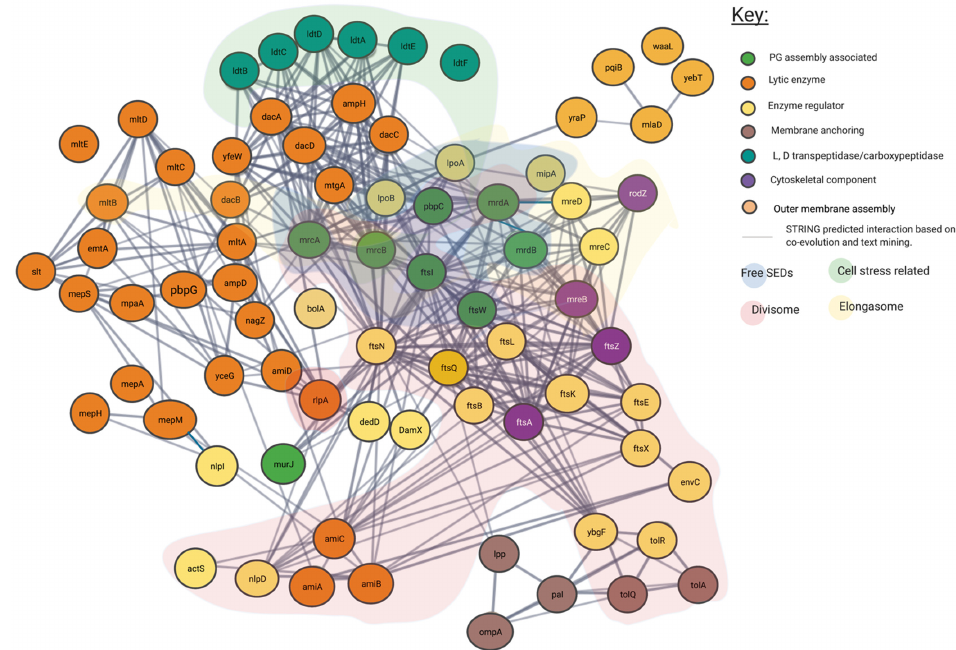
Figure 4. Predicted interaction network of peptidoglycan associated proteins using STRING. Interaction map of peptidoglycan associated proteins, sorted by enzymatic action. Network structure determined by STRING. SEDs complex interaction type is indicated by area colouring and arrows. Interactive network link: https://version-11-5.string-db.org/cgi/network?taskId=bIzLkBRoqjLb&sessionId=bBi0rwtoih3p (Last accessed on 4 November 2021).